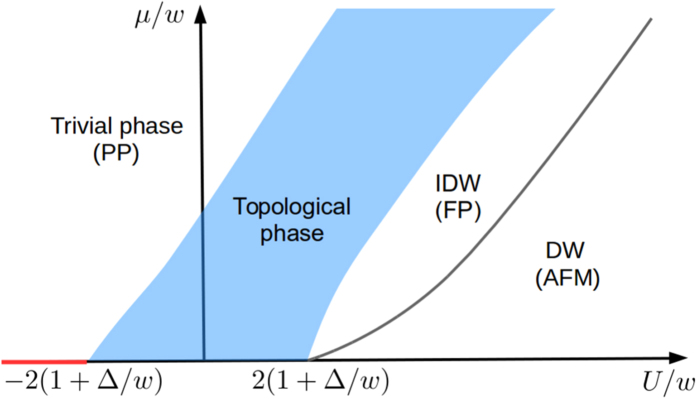
Schematic of phase diagram of the XYZ model (see, e.g.25262733).The red line is marked for the transition when μ = 0 and U < −2(1 + |Δ|/w)w.